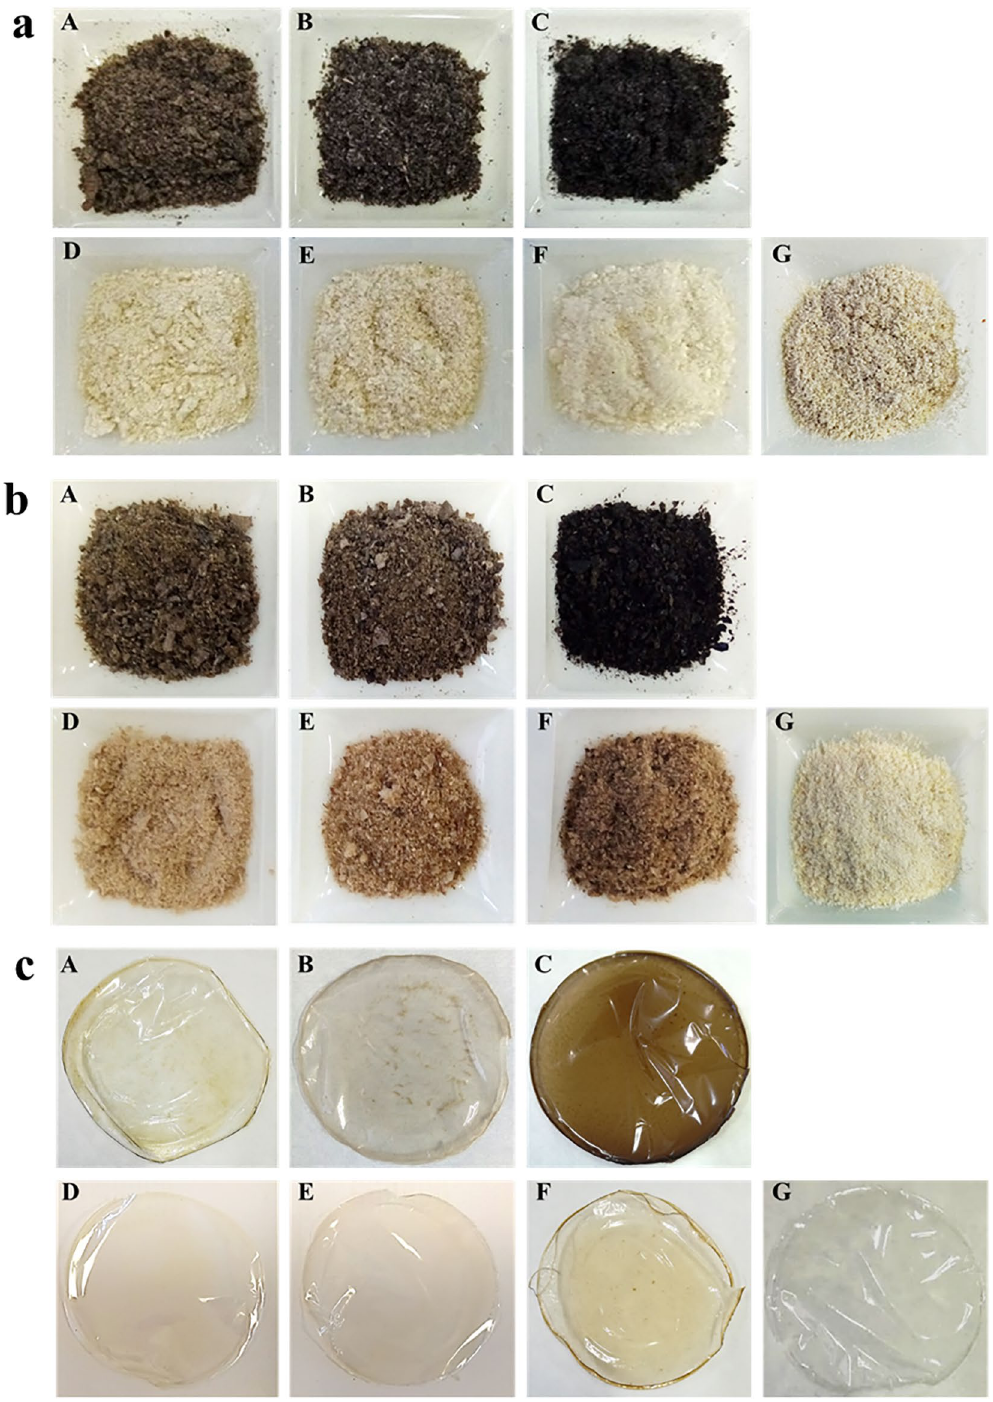
Figure 1. (a) Unbleached (A,B,C) and bleached (D,E,F) chitins extracted from H. illucens larvae (A,D), pupal exuviae (B,E) and dead adults (C,F). Commercial chitin produced from crustaceans is also shown (G); (b) unbleached (A,B,C) and bleached (D,E,F) chitosan produced from H. illucens larvae (A,D), pupal exuviae (B,E) and dead adults (C,F). Commercial chitosan derived from shrimp shells is also shown (G); (c) films obtained from unbleached (A,B,C) and bleached (D,E,F) chitosan produced from H. illucens larvae (A,D), pupal exuviae (B,E) and dead adults (C,F). Film obtained from commercial chitosan is also reported